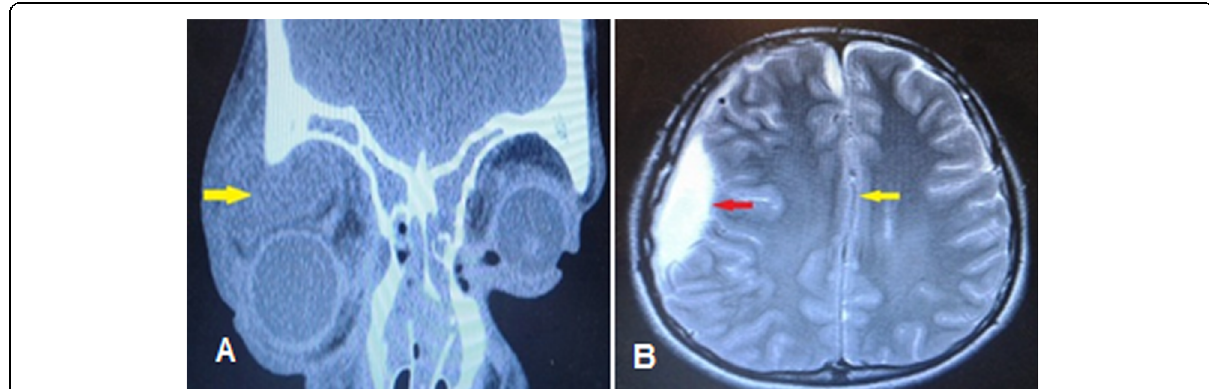
Fig. 6 A 10-year-old boy with large supra-temporal orbital abscess progressed to subdural empyema. a Orbital computed-tomography scan coronal soft tissue view shows bilateral pansinusitis and right supra-temporal abscess (yellow arrow) with inferior globe displacement. b Brain MRI